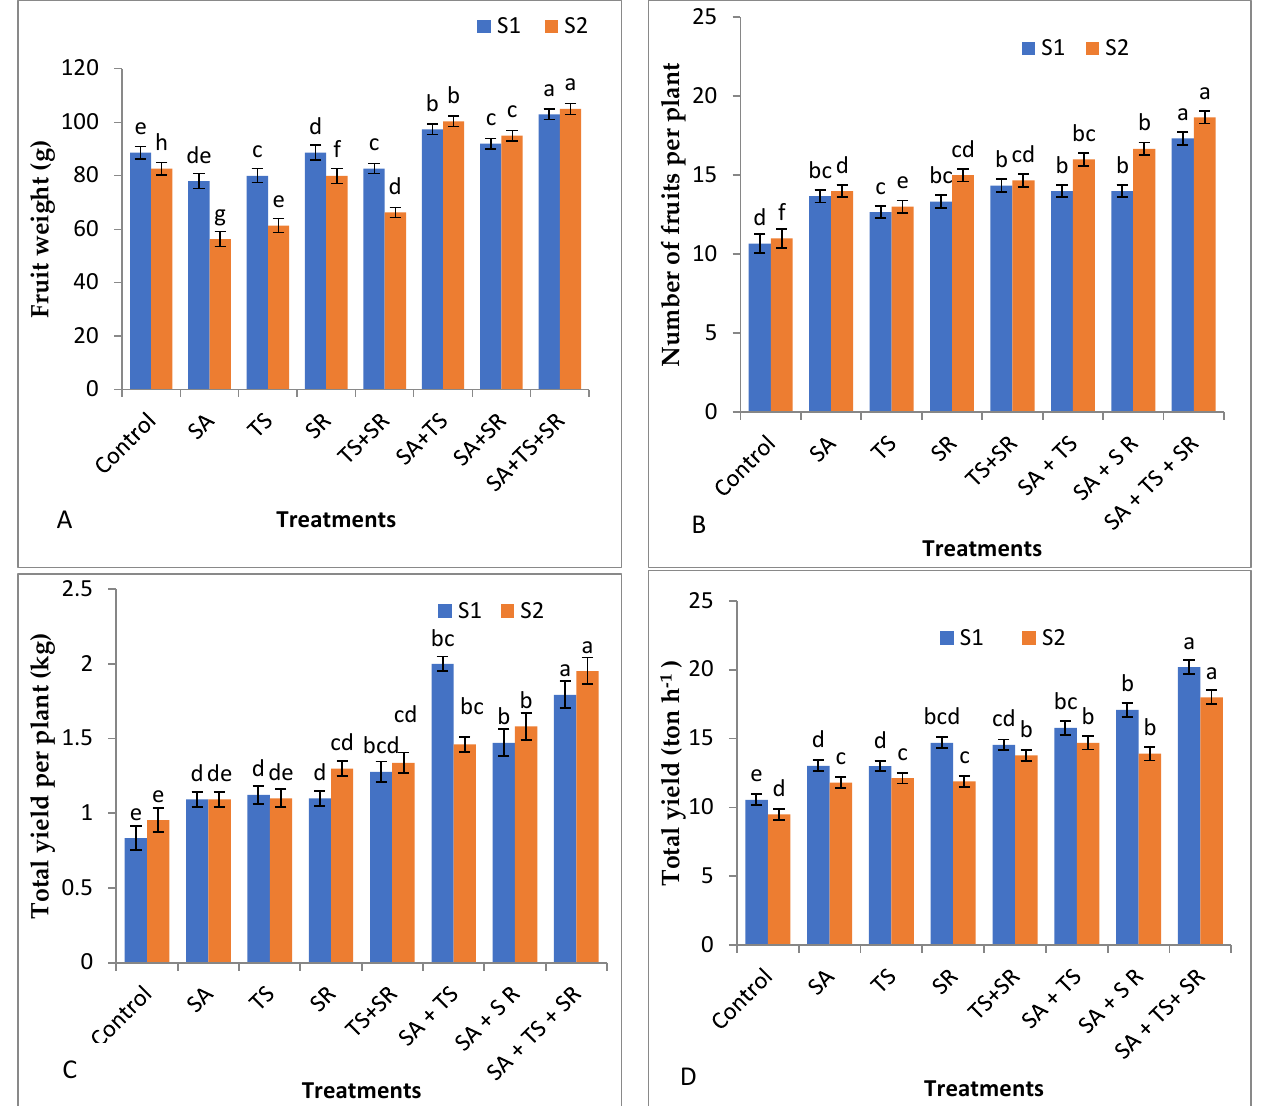
Figure 3. Effect of shikimic acid (SA) seed priming rates 40 ppm and foliar applications of water (control), T. asperellum (TS), S. rochei (SR), T. asperellum + S. rochei + (TS+SR), shikimic acid + T. asperellum (SA+TS), shikimic acid + S. rochei (SA+SR), and shikimic acid + T. asperellum + S. rochei (SA+TS+SR) on ( A ) average fruit weight (g), ( B ) number of fruits per plant, ( C ) total fruit yield per plant (kg), and ( D ) total fruit yield per hectare during two seasons. Standard errors of the mean are shown as vertical bars; the LSD test indicates that differences between values in each bar that are marked by different letters are significant at p ≤ 0.05.